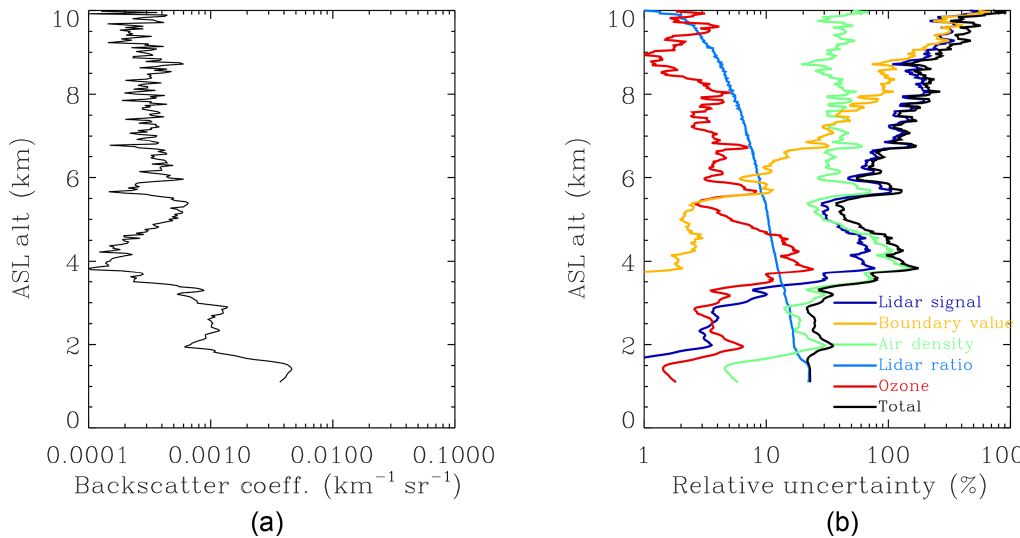
Figure B1. An example of (a) aerosol backscatter profile retrieved from 10min ozone lidar data at about 08:30UTC on 22 June 2013 and (b) the retrieval error budget for different uncertainty sources. The lidar data were from the channel-3 receiving system, which covered most of the measurement altitude range, and was arbitrarily chosen for a cloud-free